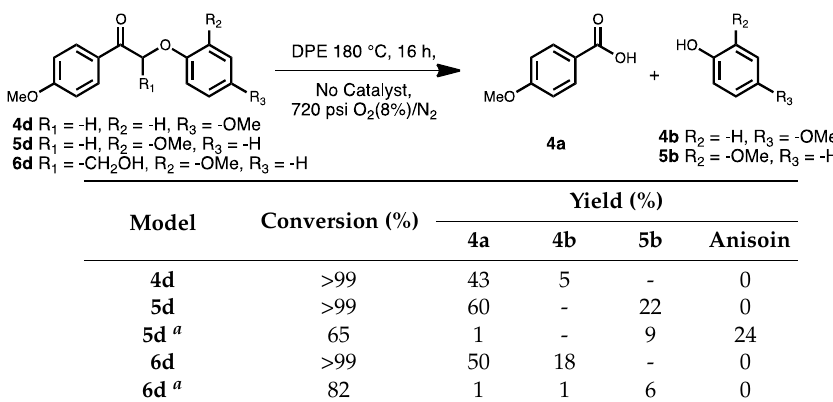
Table 12. Conversion of 4d – 6d in phenyl ether with O 2 .